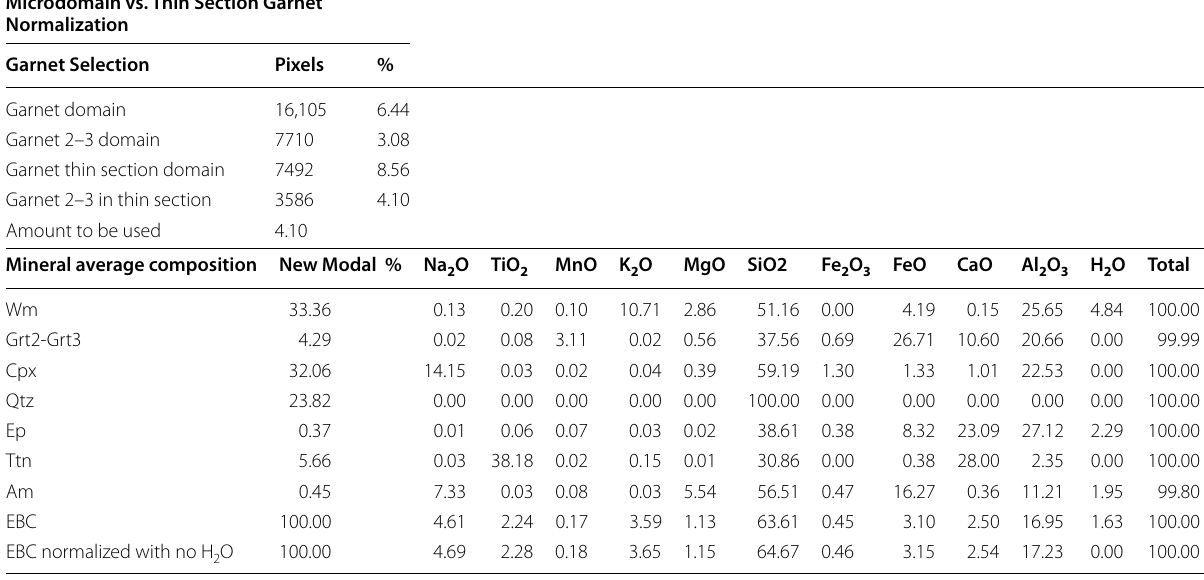
Table 10 Definition of the ERV and calculation of the EBC of the garnet-bearing gneiss (ZR4) Microdomain vs. Thin Section Garnet